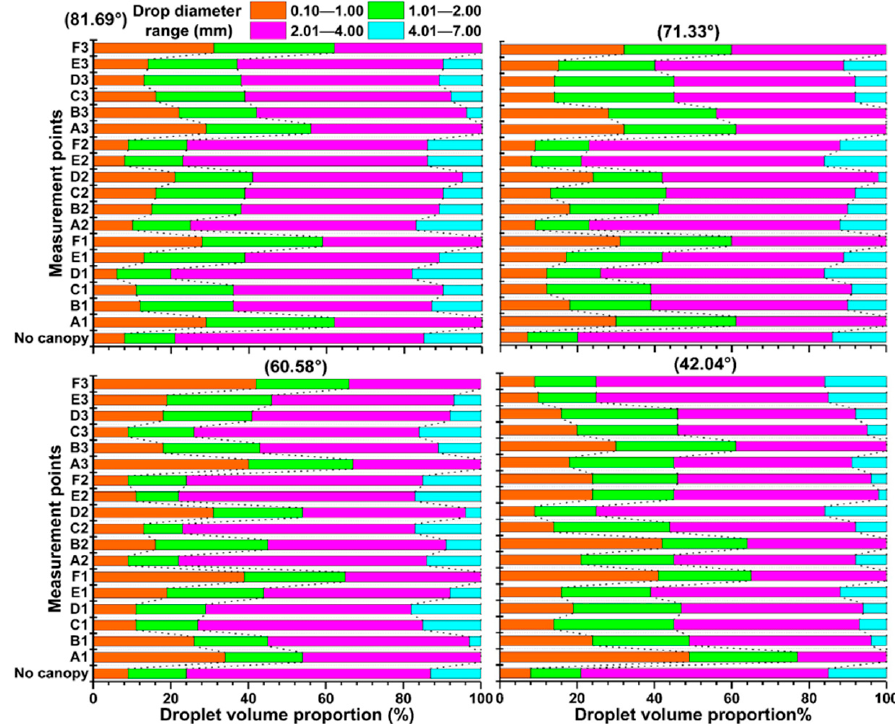
Figure 9. Volume proportion of droplets in different diameter ranges under different treatments. The significant differences in the percentage of drop volume with droplet size less than 2.00 mm, at different measurement points and treatments, is shown in Figure 9. The fluctuations of share of droplet volume with diameter less than 2.00 mm ranged from 20–62% (81.69 ◦ ), 21–61% (71.33), 22–67% (60.58 ◦ ), and 25–77% (42.04 ◦ ), respectively. The mean values of proportion of that droplet volume and their percentages of uncrowned for different treatments were 39.78% (189.43%, 81.69 ◦ ), 41.28% (206.40%, 71.33 ◦ ), 42.61% (177.54%, 60.58 ◦ ), and 46.61% (221.95%, 42.04 ◦ ), separately. Consequently, the volume shares of small droplets showed a pattern of larger values within canopy than uncrowned, and the smaller the landing angle of sprinkler irrigation droplet, the larger these values. Maize canopy and the variation of the sprinkler irrigation droplet landing angle increased the volume share of small droplets in penetrating rain. Meanwhile, the volume proportion of large drops should also be considered because of their greater soil splash capability [17]. The mean values of the volume share of droplets with drop size greater than 4.01 mm, corresponding to different treatments, were 11.57%, 11.14%, 10.23%, and 8.57%, respec- tively. From the experimental data, compared with the smaller size droplets, the volume percentage of large drops showed the opposite variation pattern. Furthermore, as the distance of the measurement points from the maize stalk changed, the volume share of drops in different size ranges was also alterated. As shown in Figure 9, when the sprinkler irrigation droplet landing angle was >45 ◦ , the volume share of droplets size less than 2.00 mm in the penetrating rain showed a spatial distribution pattern of smaller values the further away from the maize stalk, while the larger droplets (>4.01 mm) showed an opposite trend. For example, when the sprinkler irrigation droplet landing angle was 60.58 ◦ , the volume proportion of droplet diameter smaller than 2.00 mm, at A3, B3, C3, D3, E3, and F3, were 67%, 43%, 26%, 41%, 46%, and 66%, while the percentage